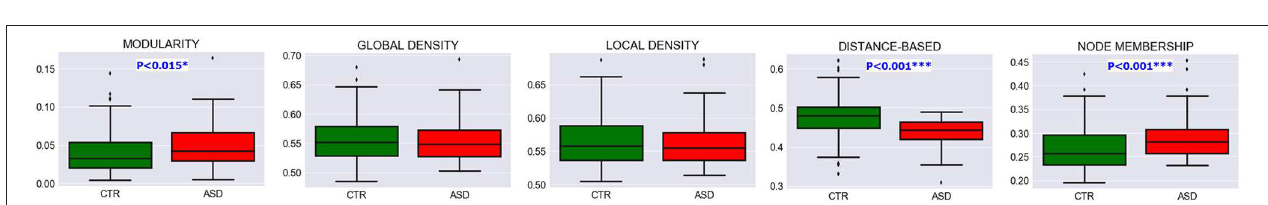
FIGURE 4 | Comparing average and standard deviation of community pattern quality metrics between patients with ASD and controls for the full range of thresholds. Community quality metrics were computed for each participant, and plots were created based on the average for patients with ASD and controls. Each row represents a dataset and each column one metric. Group statistical differences were analyzed using the two-sample Kolmogorov-Smirnov test. Only significant FDR-corrected p -values are reported ( p < 0.05).